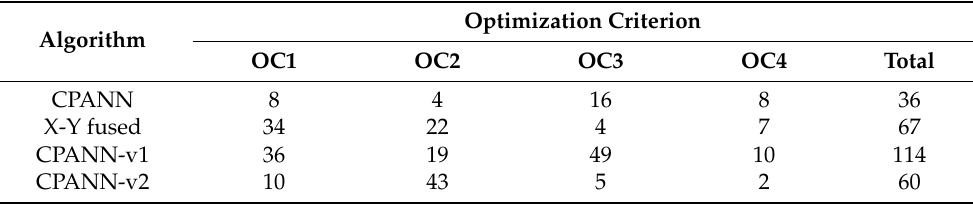
Table 2. Number of selected models obtained when using an initial set of 49